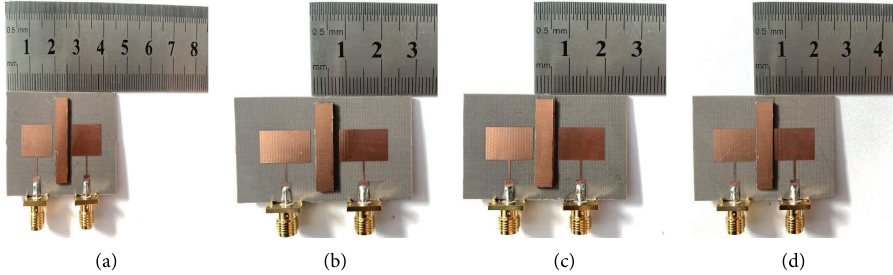
Figure 10: Photographs of the proposed array fabrication (unit: mm). (a) Proposed array design by EM simulation. (b) Proposed array predicted by FCNN ( L � 8). (c) Proposed array predicted by FCNN ( L � 7). (d) Proposed array predicted by FCNN ( L � 6).